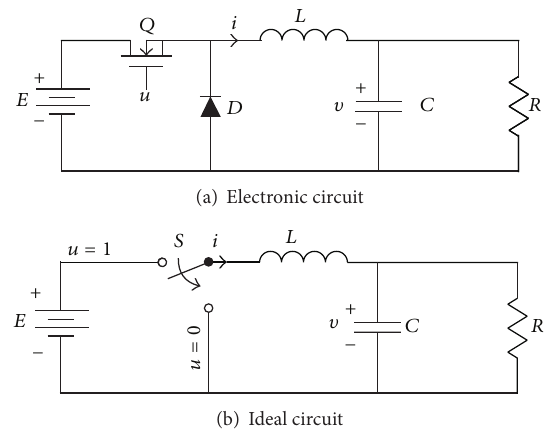
Figure 1: DC/DC Buck power